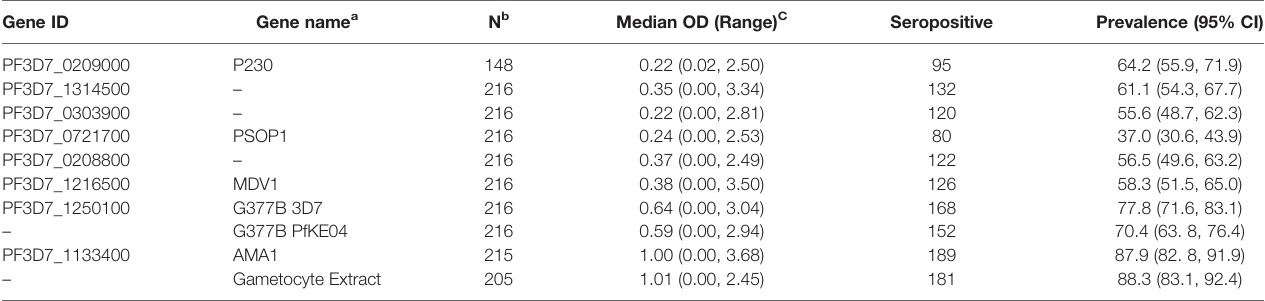
TABLE 4 | Seroprevalence of antibody responses to the gametocyte antigens, AMA1 and gametocyte extract. Gene